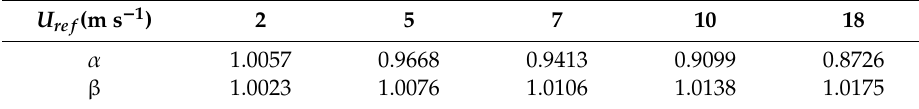
Table 6. Parameters α and β of the power law best-fit curves at di ff erent wind speeds ( U ref